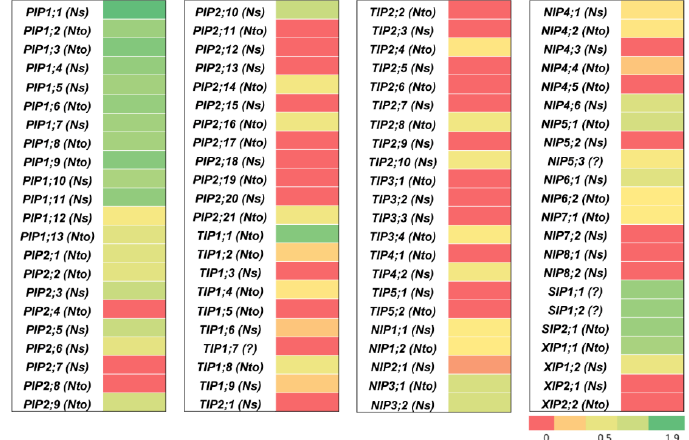
Figure 6. Expression analyses of 88 NtAQP genes in N. tabacum BY-2 cells. Color scale represents logarithmic FPKM values, where green indicates high expression and red indicates no expression or very low expression. Ns and Nto in parentheses indicate that corresponding NtAQP gene evolved from N. sylvestris (Ns) or N. tomentosiformis (Nto). Question mark (?) indicates that NtAQP gene origin ( N. sylvestris or N. tomentosiformis ) was not